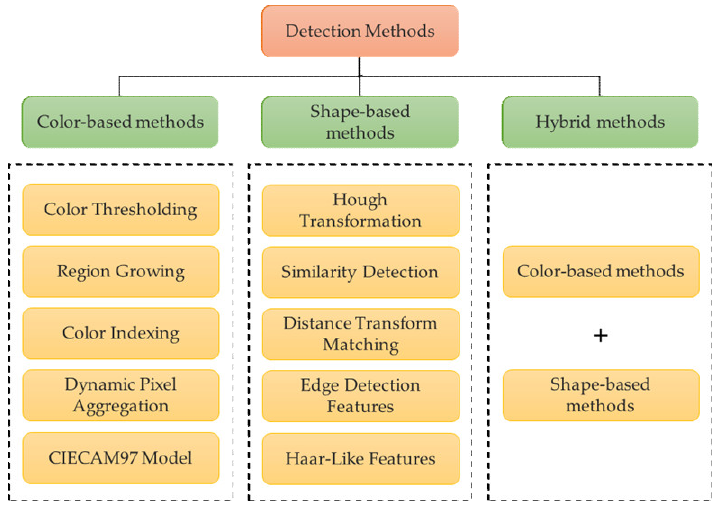
Figure 2. Most popular methods applied for traffic sign detection [11].